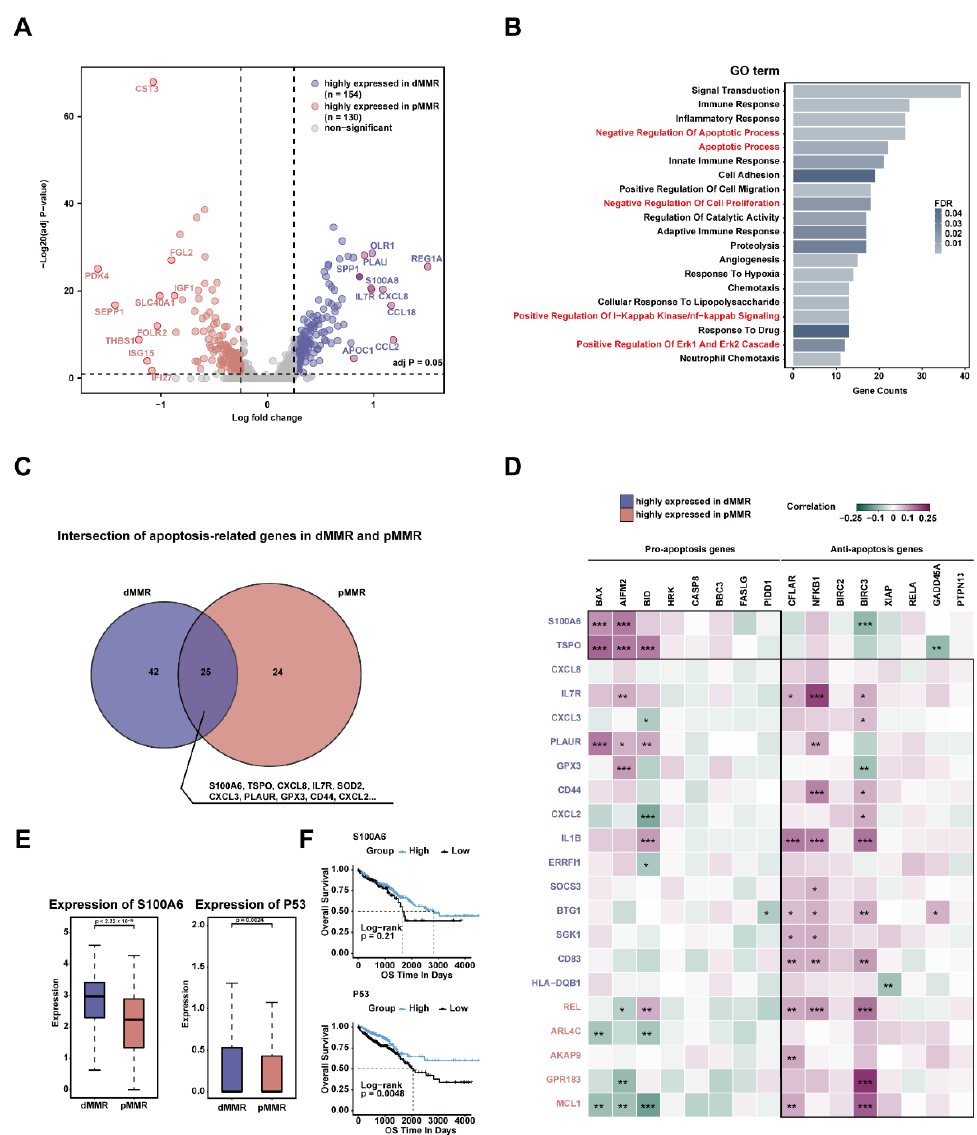
Figure 4. Screening for genes associated with apoptosis of M2c-like TAMs in dMMR: ( A ) a volcano plot shows differentially expressed genes of M2c-like TAMs in dMMR and pMMR. The top 10 differ- entially expressed genes (DEGs) upregulated in dMMR and pMMR are labeled; ( B ) the top 20 GO terms significantly enriched by the 284 DEGs (FDR < 0.05). Pathways associated with proliferation or apoptosis are marked in red; ( C ) the intersection of DEGs obtained by lasso screening related to dMMR and pMMR apoptosis scores; ( D ) the heatmap shows the Pearson correlation